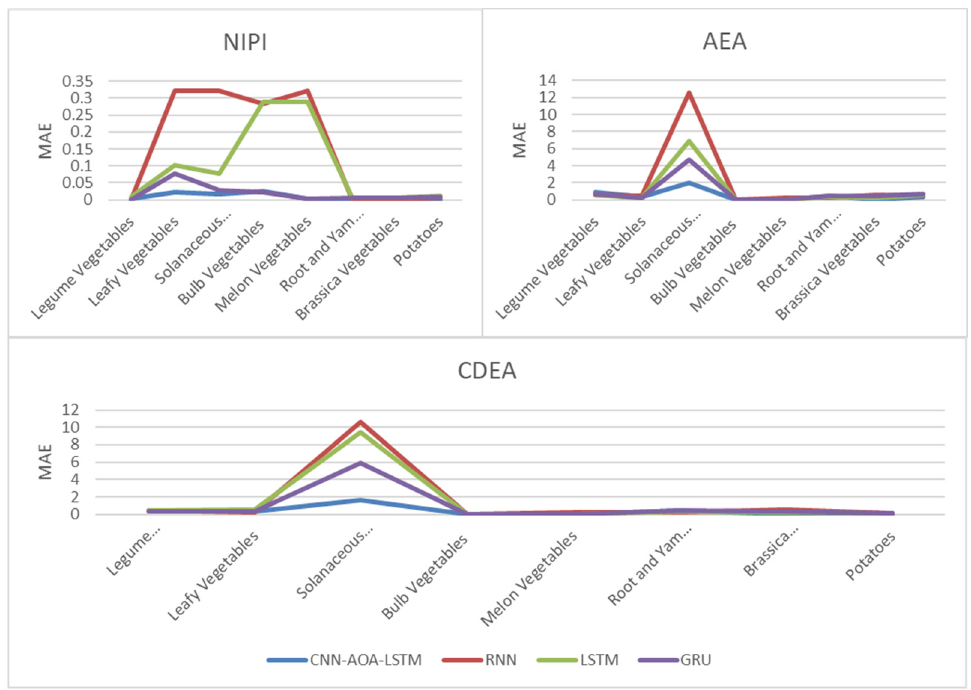
Figure 17. MAE of NIPI, AEA and CDEA indexes.